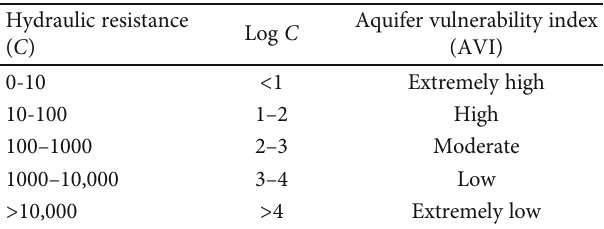
Table 2: Relationship of aquifer vulnerability index to hydraulic resistance (from [11]).